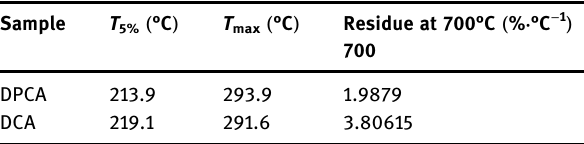
Table A1: The TGA data of DPCA and DCA under nitrogen atmosphere Sample